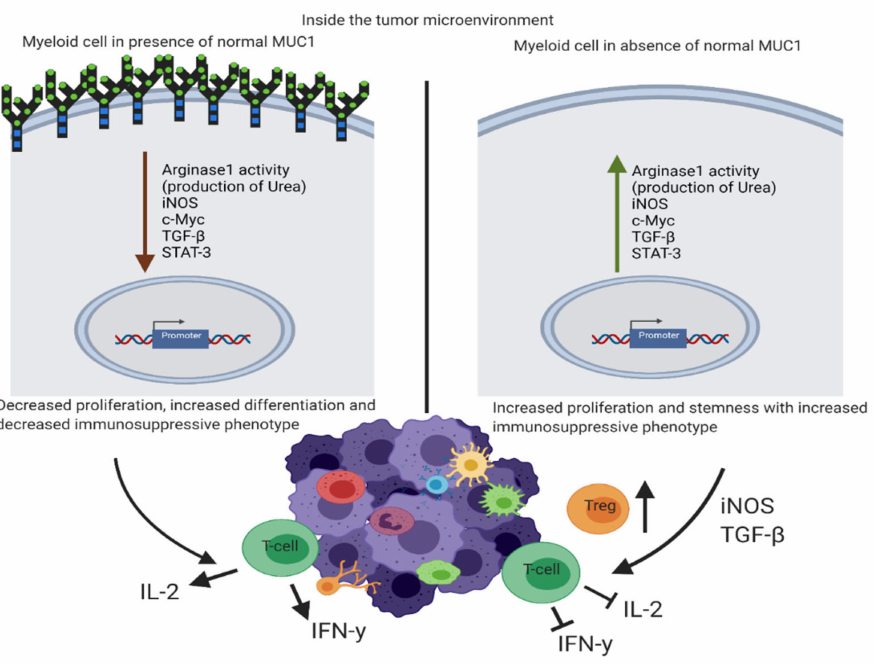
Figure 6. Schematic diagram showing the differences in the tumor microenvironment of a MUC1KO mouse versus that of a WT mouse. Schematic diagram showing the differences in the tumor mi- croenvironment of a MUC1KO mouse (right) vs that of a WT mouse (left). Red arrow indicates downregulation and green arrow indicates upregulation of genes. MUC1KO mouse have increased TGF- β and T-reg cells in their tumor microenvironment thus. MDSCs from MUC1KO mouse produce higher urea, iNOS, stemness marker Sca1, and TGF- β , and show increased expansion and migration into the tumor, thus inhibiting T cells from producing IL-2 and IFN- γ